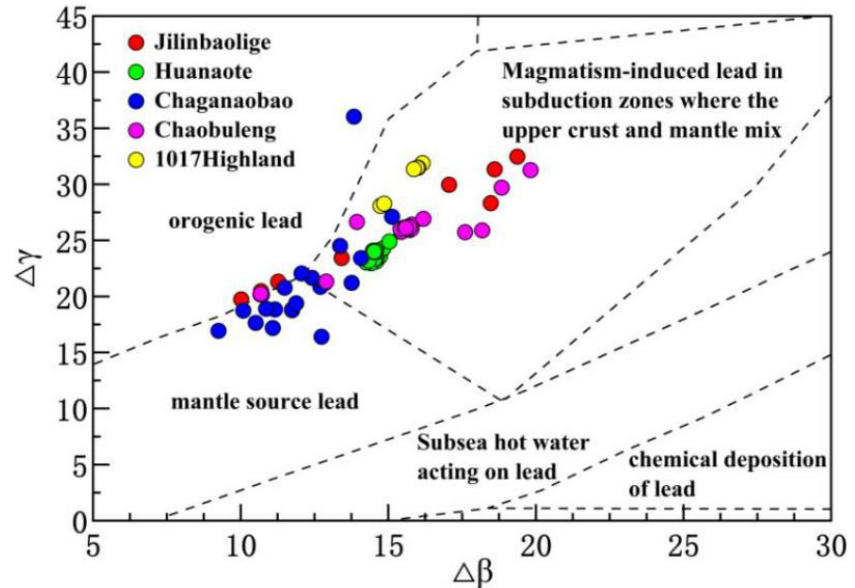
Figure 8. Diagram of Δγ – Δβ genetic classification of lead isotopes of main metal deposits in the southern part of the Great Xing’an Range. Some data of the ore lead isotope compositions are from Yang [15], Zhang et al. [9], Chen [41], and Jia et al. [40]. Figure modified according to Zhu